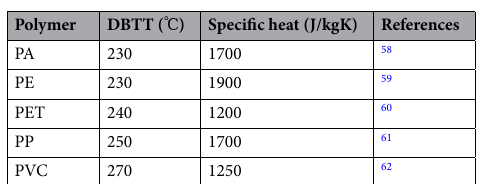
Table 2. Properties of plastics applied to freezing and